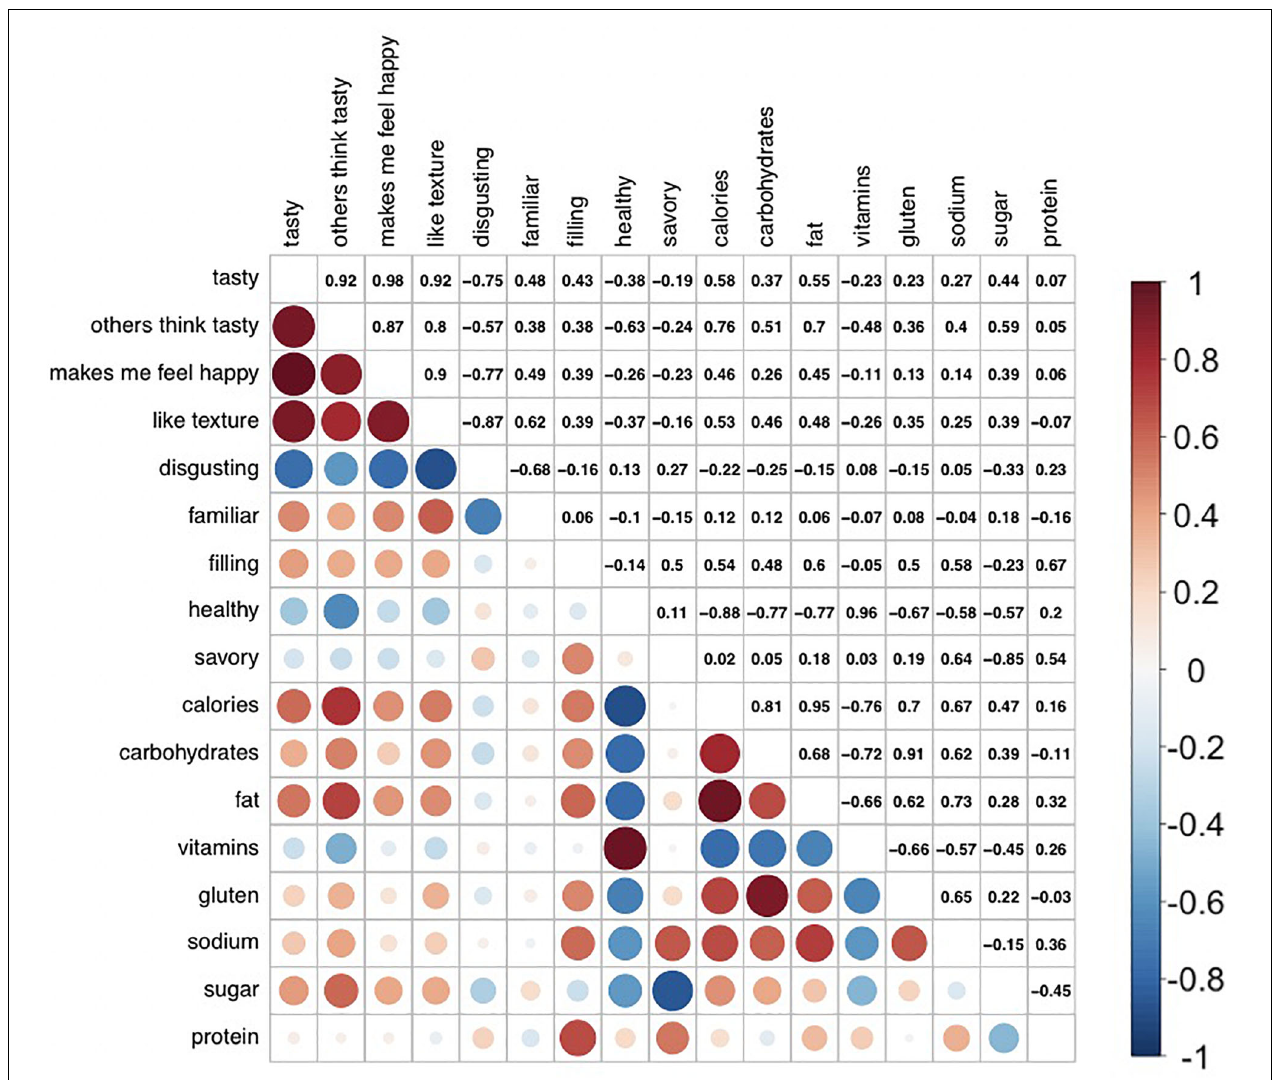
FIGURE 5 | Correlations between subjective rating dimensions across stimulus set. The matrix shows Pearson R correlations (described using a heat-map function and numeric values), which index the strength of association between each pair of attribute ratings. The mean for each attribute rating, for each food, was calculated using all available participant ratings. Correlations between average attribute ratings across all foods were then determined, indicating strong correlations between multiple of the